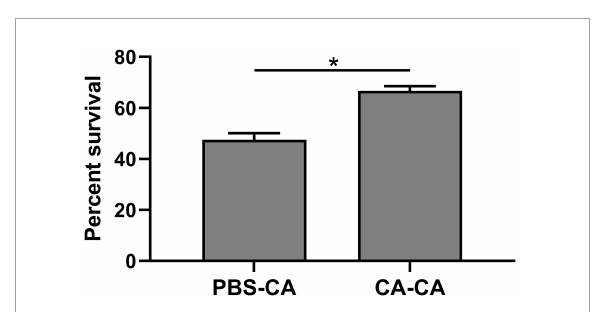
FIGURE4 Survival of offspring larvae 24 h post-challenge. Parental adults were first primed by injection of heat-killed C. albicans (CA) or injection of PBS as injury control (PBS), and offspring larvae were challenged with a lethal dose of C. albicans. The survival data of each condition were generated from three replicates, and each had 80 larvae. The survival difference was compared using the Log-rank test of the Kaplan-Meier survival analysis. The results are reported as mean ± SE from 3 independent experiments. Asterisk indicates significant differences between priming treatment and PBS control (* P <